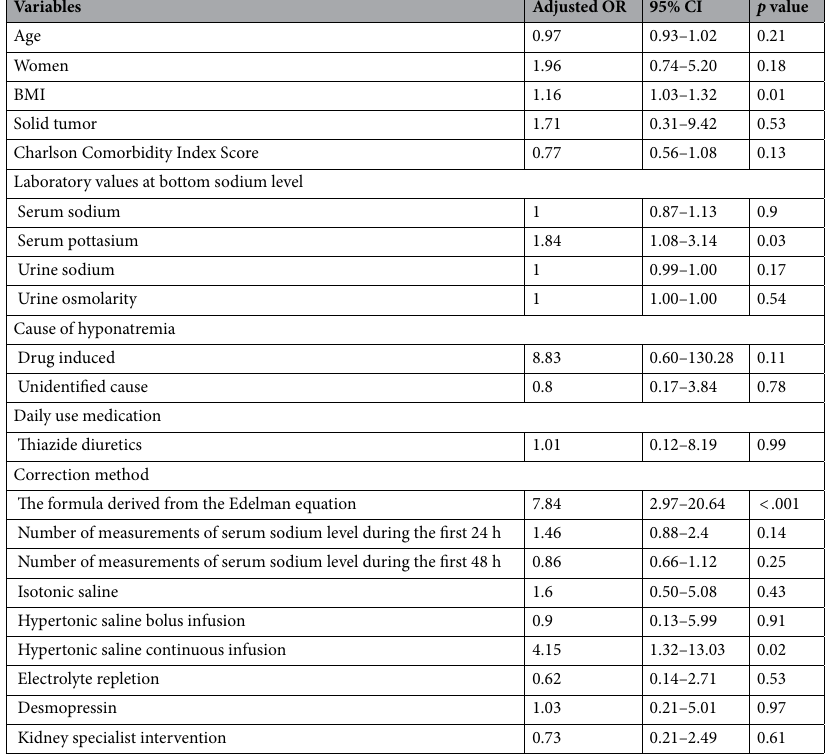
Table 2. Factors associated with appropriate correction of serum sodium concentration in patients with the serum sodium concentration ≤ 120 mEq/L. OR odds ratio; 95% CI, 95% confidence interval.